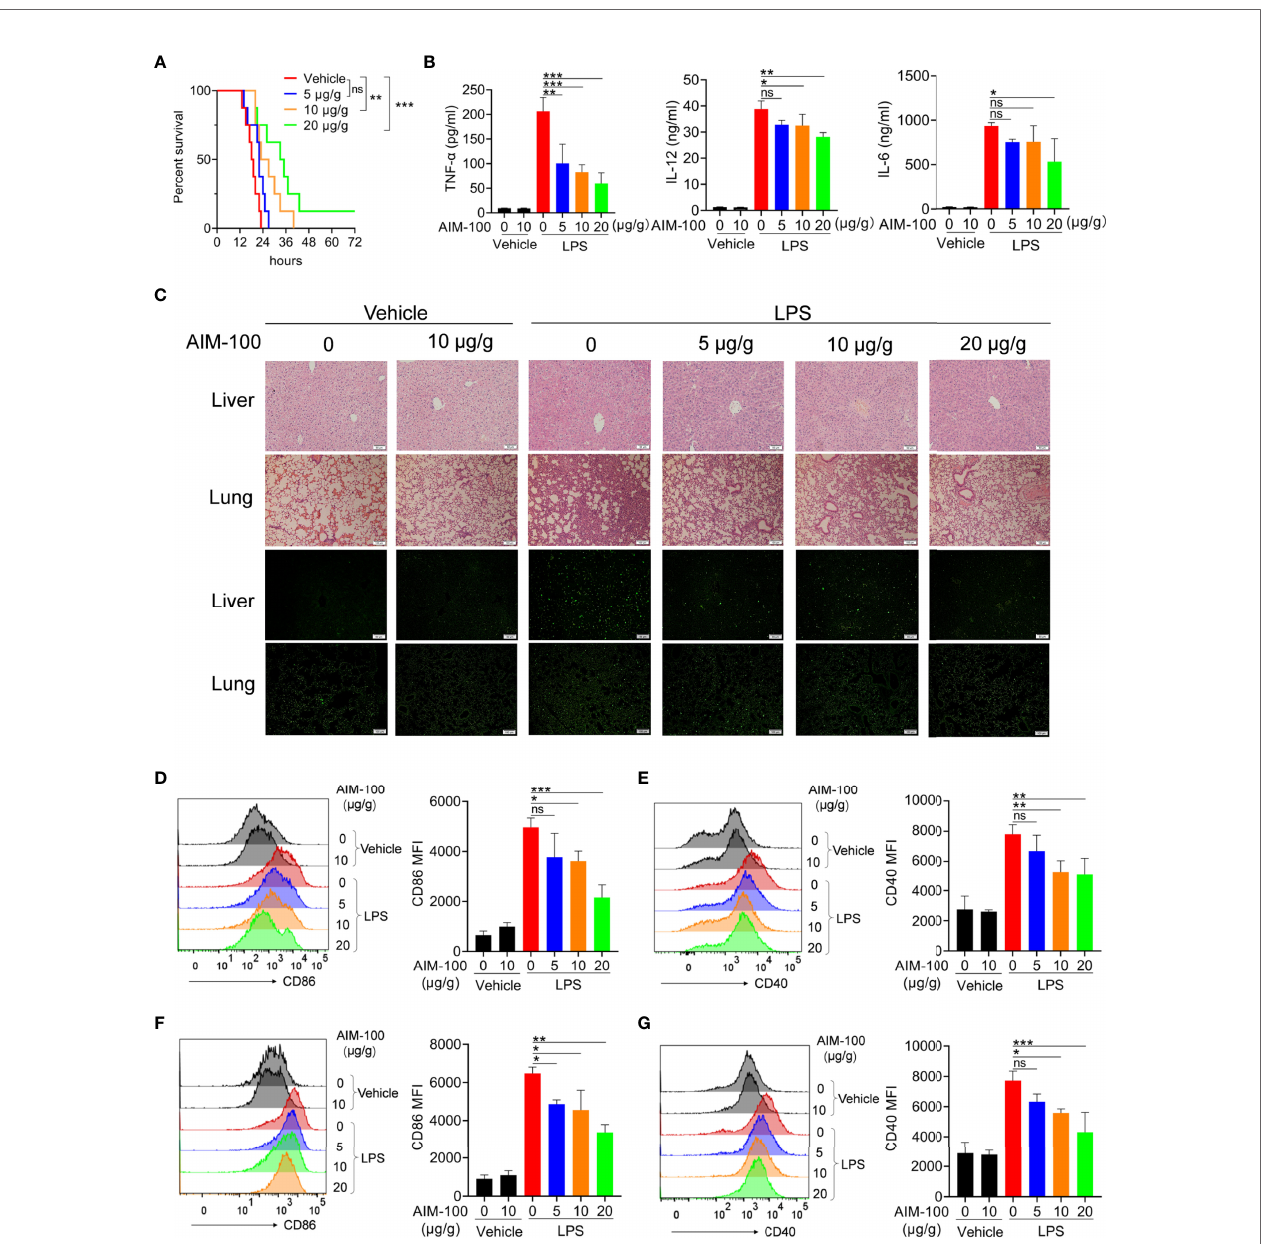
FIGURE 5 | Pharmacological inhibition of ACK1 ameliorates mice with endotoxic shock. (A) C57BL/6 mice were injected AIM-100 (5, 10, 20 m g/g body weight) or vehicle for 2 hours followed by LPS challenge (37.5 m g/g of body weight), and the mortality of mice were observed (n = 8 mice/group). Survival curves were estimated by using Kaplan – Meier method and the Log-rank test was applied to determine the differences of survival rate. Statistically signi fi cant was assumed for P < 0.05 ( ∗ ), P < 0.01 ( ∗∗ ), P < 0.001 ( ∗∗∗ ), and ns, not signi fi cant. (B – G) C57BL/6 mice were injected AIM-100 (5, 10, 20 m g/g body weight) or vehicle for 2 hours followed by LPS challenge (10 m g/g of body weight). ELISA measures the levels of TNF- a , IL-6 and IL-12 in serum at 3 hours (B) . The lungs and livers of the endotoxic shock model mice were soaked in 4% paraformaldehyde and then paraf fi n embedded were stained with H&E at 12 hours (C) . TUNEL analysis of apoptosis of lung and liver cells at 12 hours (C) . The expression levels of CD40 and CD86 on splenic F4/80 + macrophages (D, E) and CD11c + DCs (F, G) of endotoxin shock mice were detected by fl ow cytometry at 12 hours. The data are shown as the means ± SEM (n=6 mice/group) and are representative of three independent experiments. * p < 0.05, ** p < 0.01, *** p < 0.001, as determined by ANOVA tests; ns denotes p >